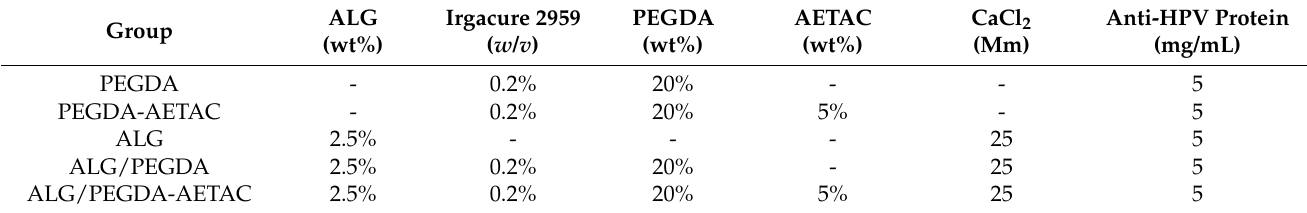
Table 1. Ingredients in hydrogels loaded with anti-HPV